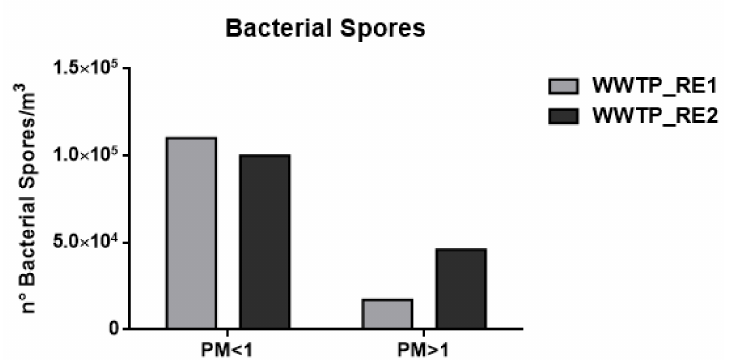
Figure 3. Number ( ◦ ) of total bacterial spores / m 3 in the wastewater treatment plant (WWTP). Sampling campaign WWTP_RE1 (first period) and WWTP_RE2 (second period).